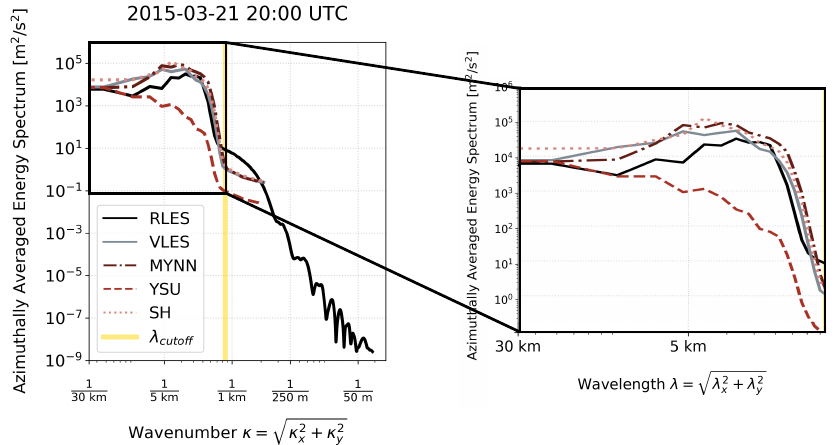
Figure 6. Example of azimuthally averaged power spectra of vertical velocity perturbations for the five simulation approaches. The left panel shows the entire wavenumber range, and the right panel shows the wavelength range considered in the analysis, starting at λ cutoff